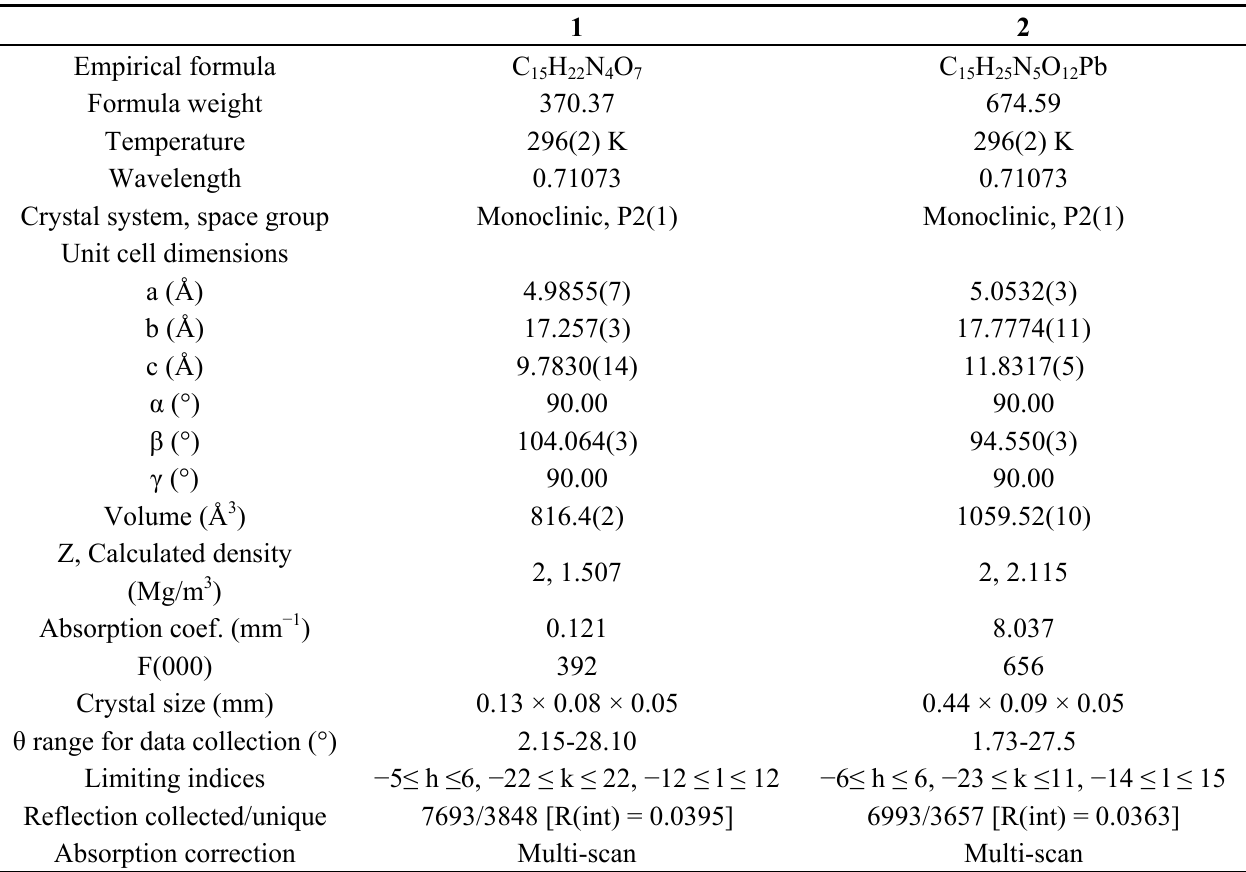
Table 1. Selected crystallographic data of 1 and 2